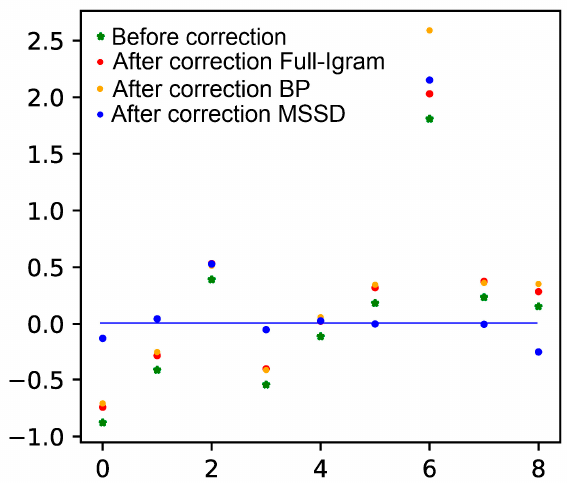
Figure 10. Correlation coe ffi cients of 9 sub-regions; only the absolute values of the coe ffi cients corrected by MSSD in the sub-regions 2, 4, and 6 are larger than those corrected by the full interferogram–topography correlation approach or BP approach (Table 2).